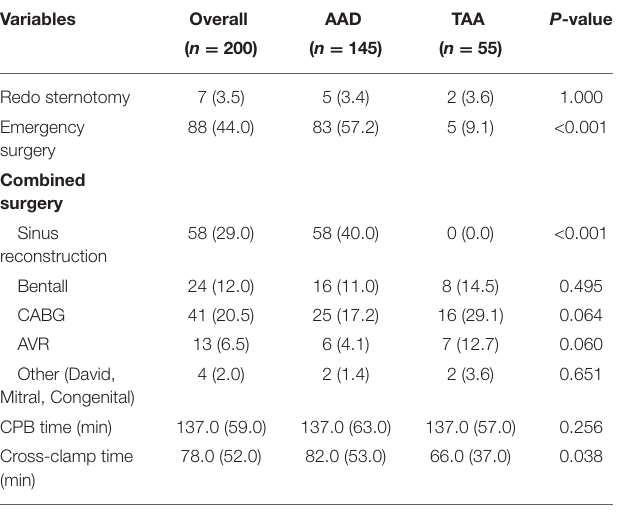
TABLE 2 | Operative details.